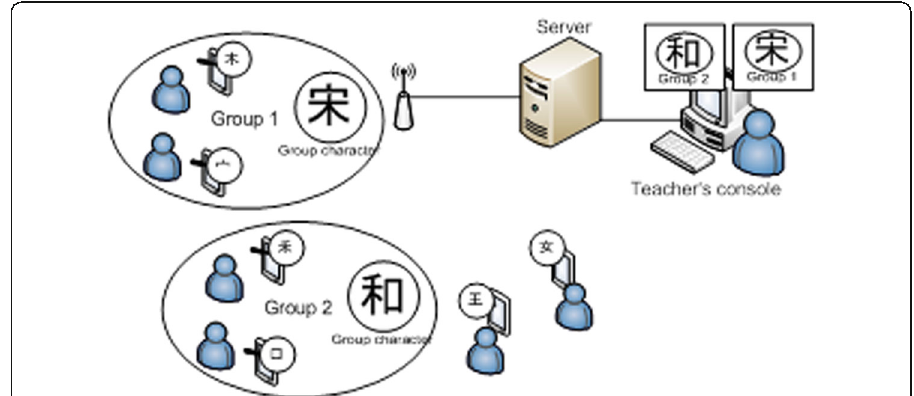
Fig. 1 A broad architecture overview of the Chinese-PP